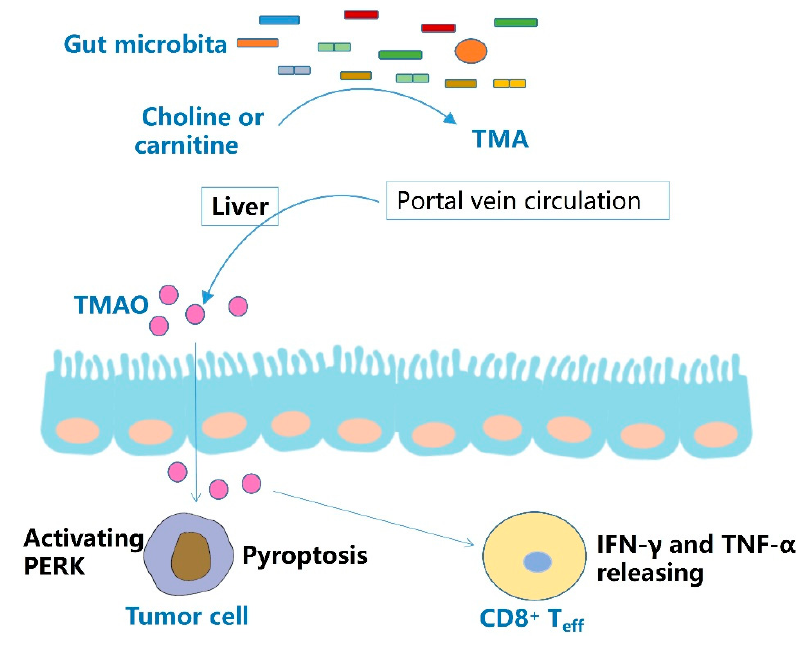
Figure 3. Effect and mechanism of TMAO.